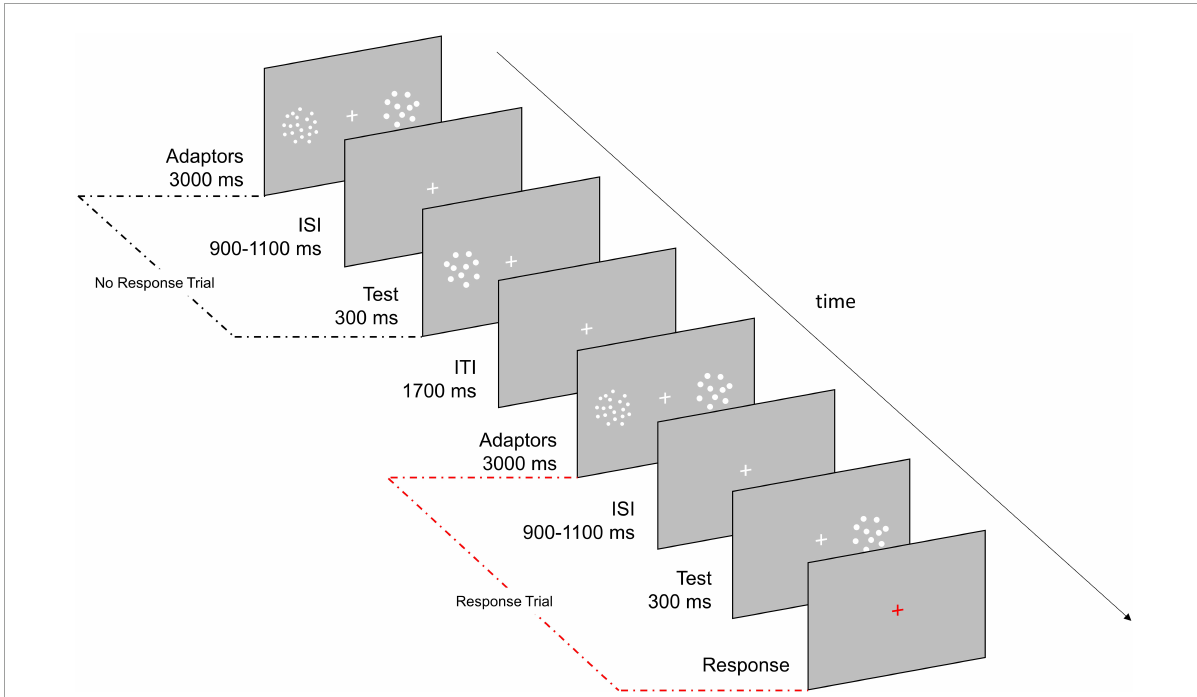
FIGURE1 Experimental paradigm. Participants were asked to estimate the numerosity of the test stimulus (22, 26, 30, 35, or 41 dots) and to verbally report it only if the fixation cross turned red (33% of trials). During adaptation the test could appear either in the location previously occupied by the High Adaptor (a cloud of 48 dots; Adaptation condition) or by the Neutral Adaptor (a cloud of dots matching the numerosity of the test; Neutral condition). In half of the blocks the High Adaptor was presented on the left while in the other half it was presented on the right . Baseline consisted in trials in which the test stimuli were not preceded by any adaptation